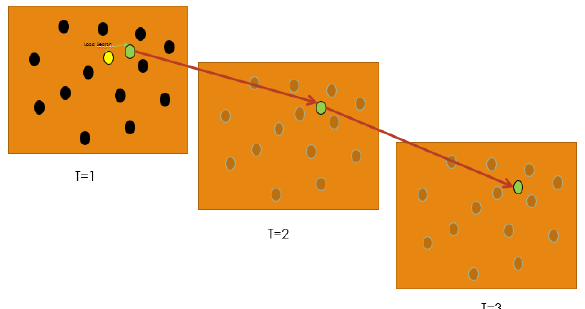
Figure 2. Time-optimal method. The green point is the robust solution found by the method, which is used in the next times.